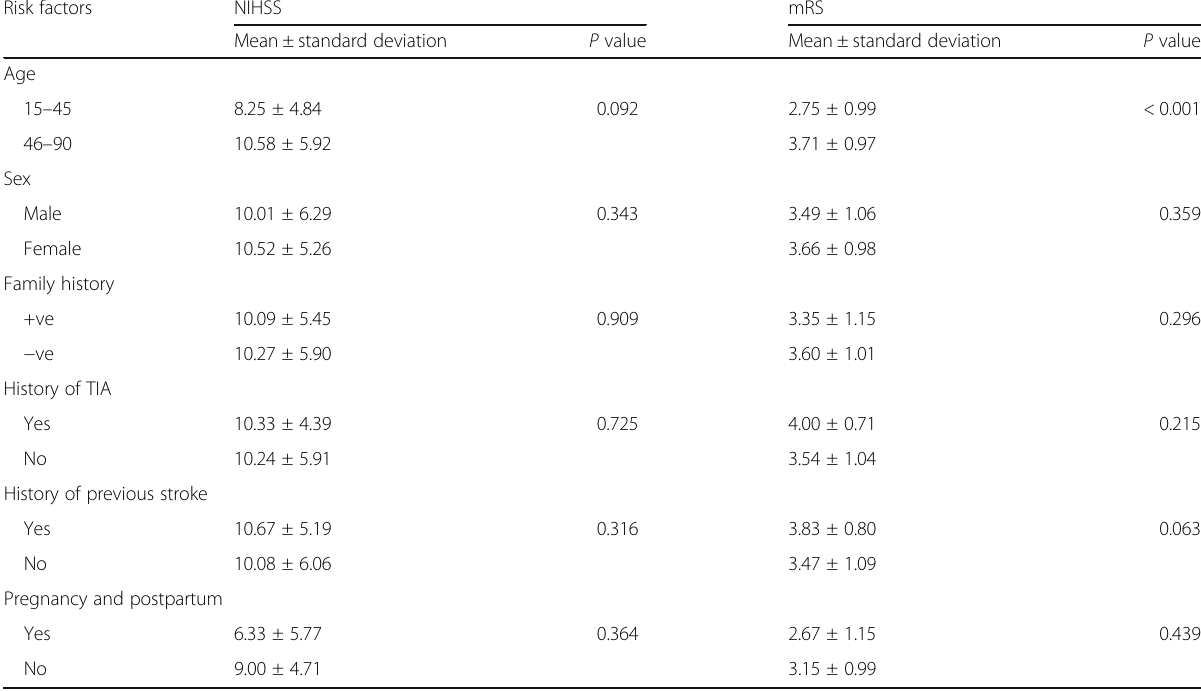
Table 5 Relation between non-modifiable risk factors and stroke severity and disability at presentation using NIHSS and mRS Risk